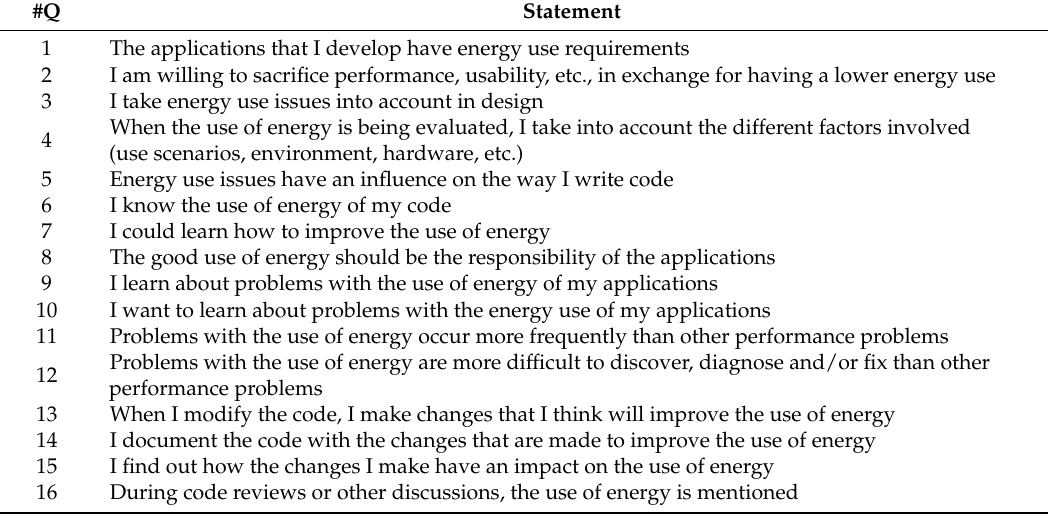
Table 2. Best practices for sustainability in the software development process (based on and adapted from Manotas et al.